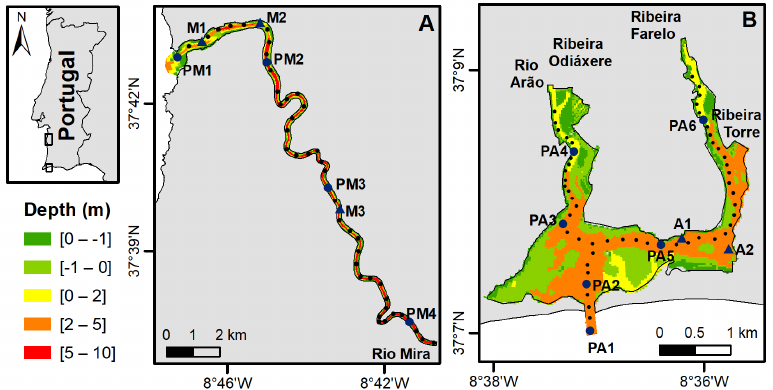
Figure 1. Bathymetry of Mira Estuary ( A ) and Ria de Alvor ( B ), with the location of the sampling stations (blue triangles), the points where the harmonic analysis and tidal asymmetry were computed (black dots), and the points where seasonal analysis of physico-chemical parameters was performed (blue dots).